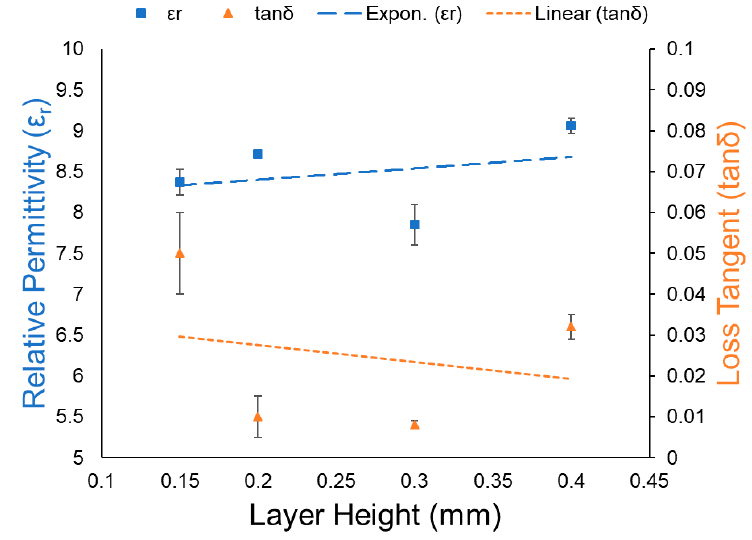
Figure 6. Layer height vs. relative permittivity ( ε r ) and loss tangent ( tan δ ).